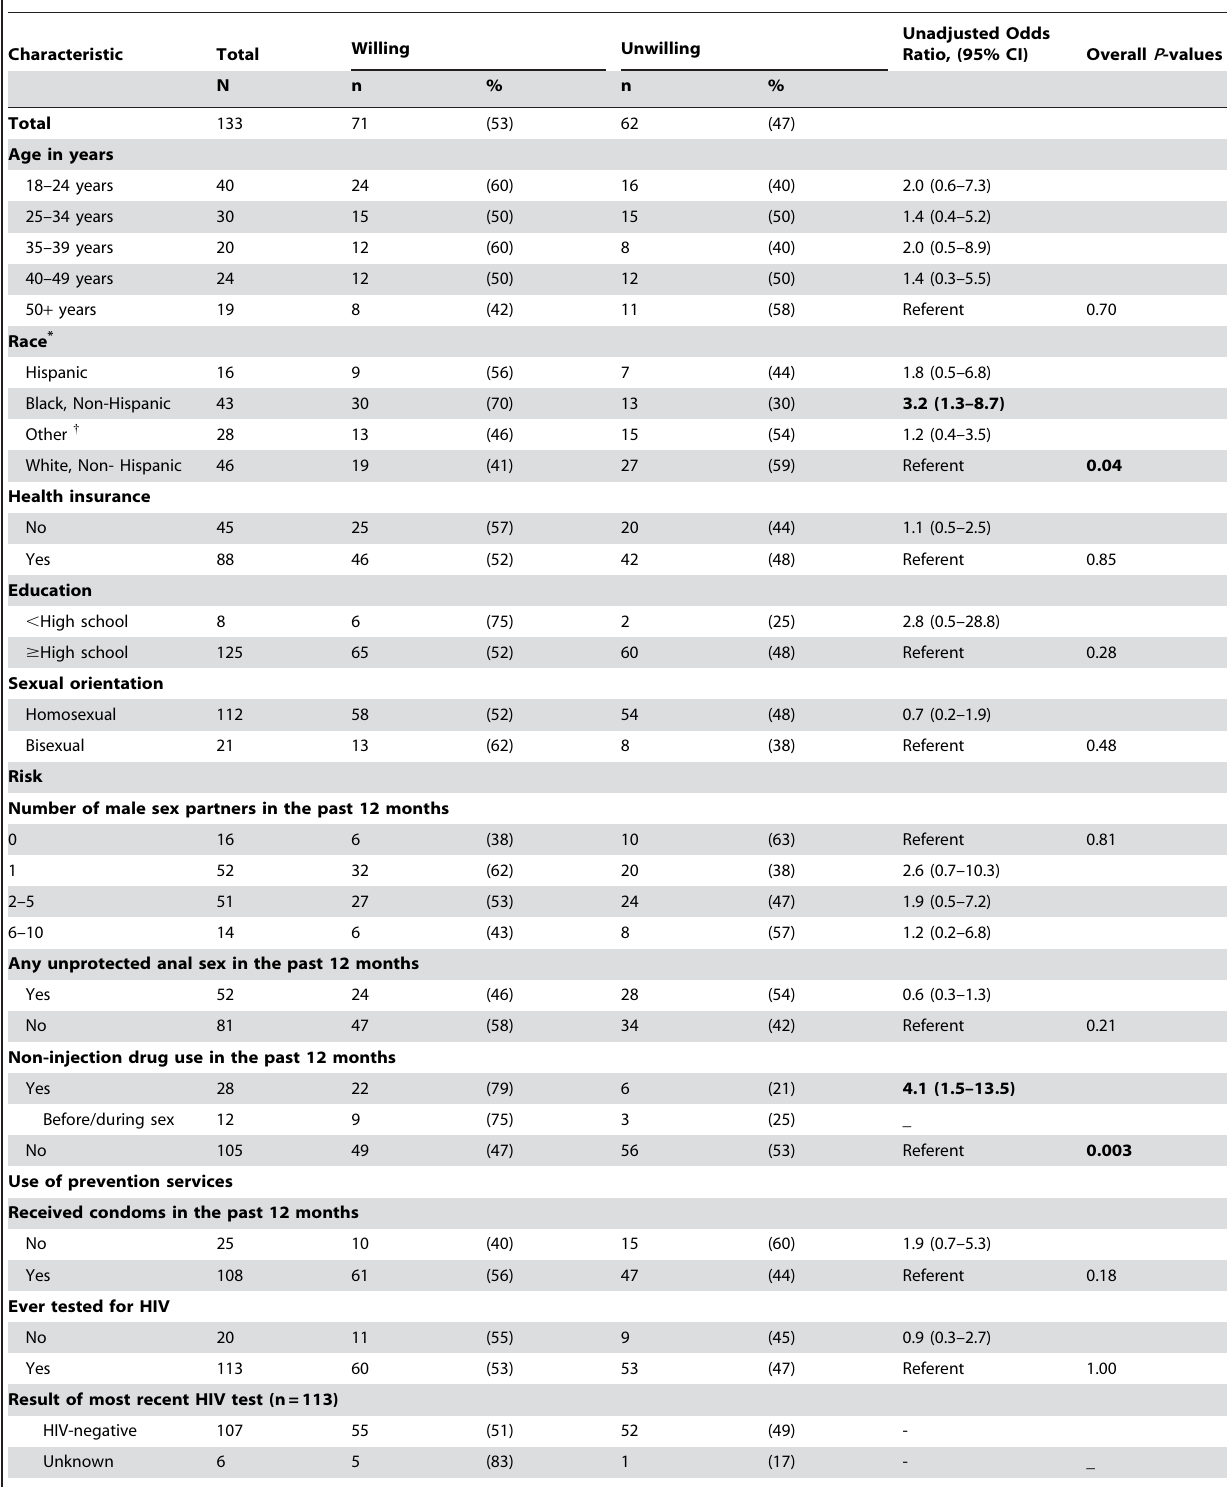
Table 2. Demographic characteristics, behavioral risk factors, HIV testing history, and use of prevention services and agreement with perceived risks and benefits of circumcision and willingness to be circumcised among 133 uncircumcised men who have sex with men not known to be HIV-infected who attended Gay Pride and Minority Gay Pride events in 7 U.S. cities by willingness to be circumcised as an adult –